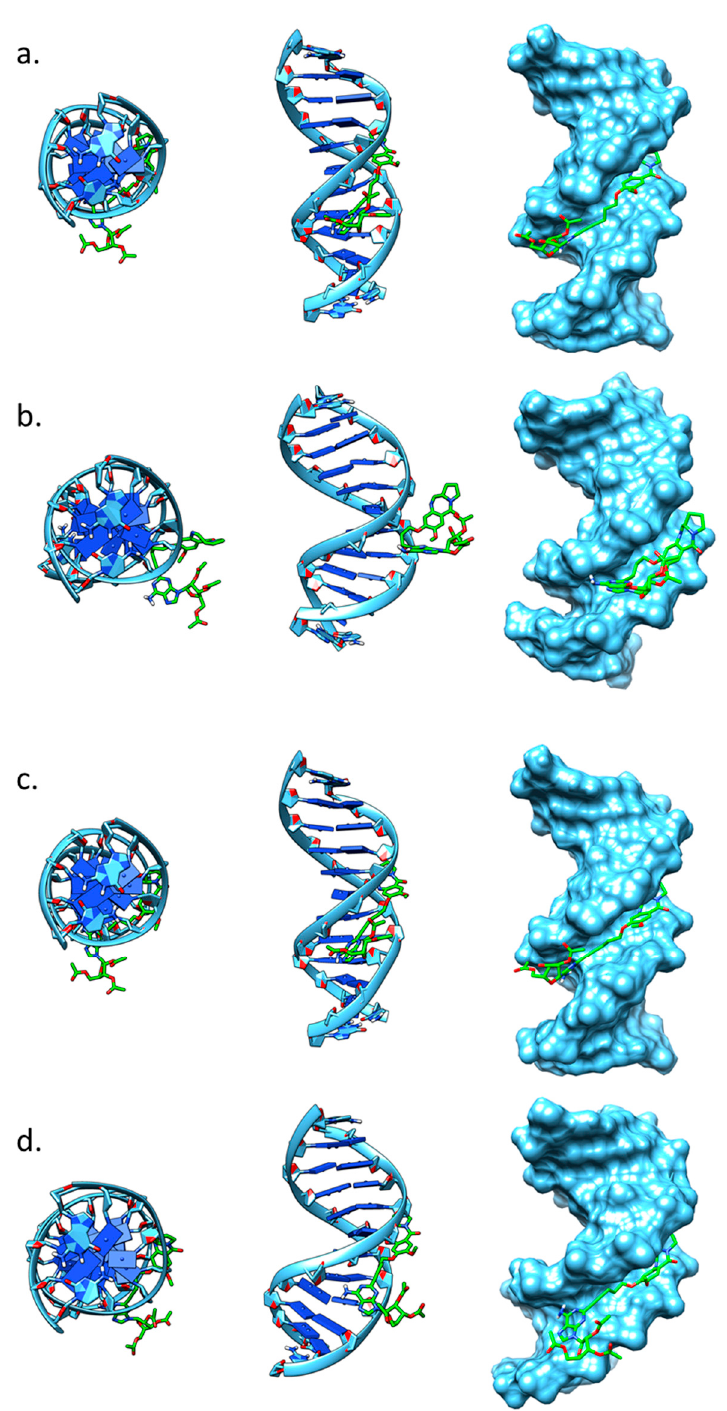
Figure 4. Images from molecular dynamics simulations of compound 16 bound to 12mer DNA sequences. Top down (left), side (center) and surface (right) representations of the DNA with the compound 16 (green). ( a and b). DNA sequence 5 ′ -CGTAGATTTGCG-3 ′ before ( a ) and after ( b ) 30 ns of solvated molecular dynamics; ( c and d) DNA sequence 5 ′ -CGTAGATCTGCG-3 ′ before ( c ) and after ( d ) 30 ns of solvated molecular dynamics.